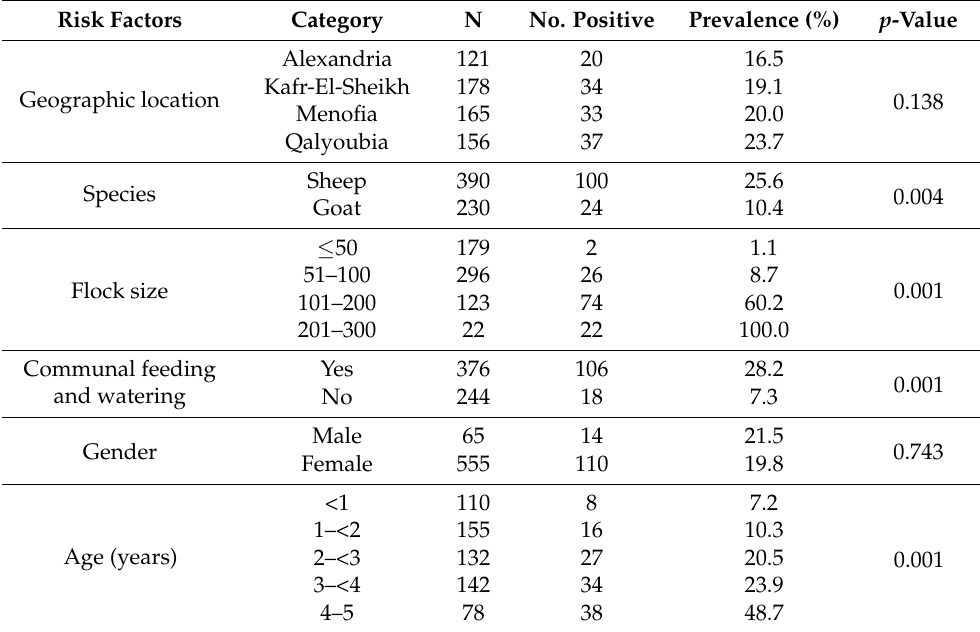
Table 1. Univariable logistic regression analysis of the association of contagious caprine pleuropneu- monia in sheep and goats with different risk factors in the Nile Delta of